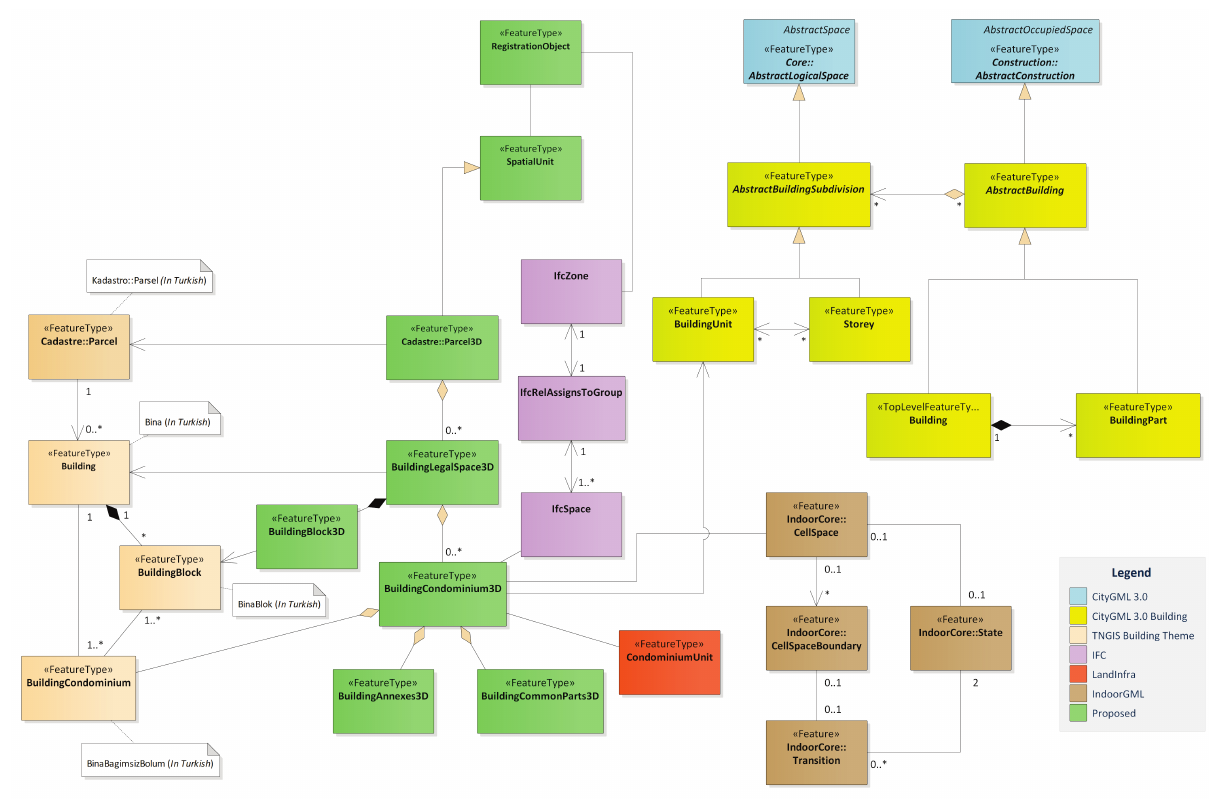
Figure 2. An integrated model for 3D registration of condominium